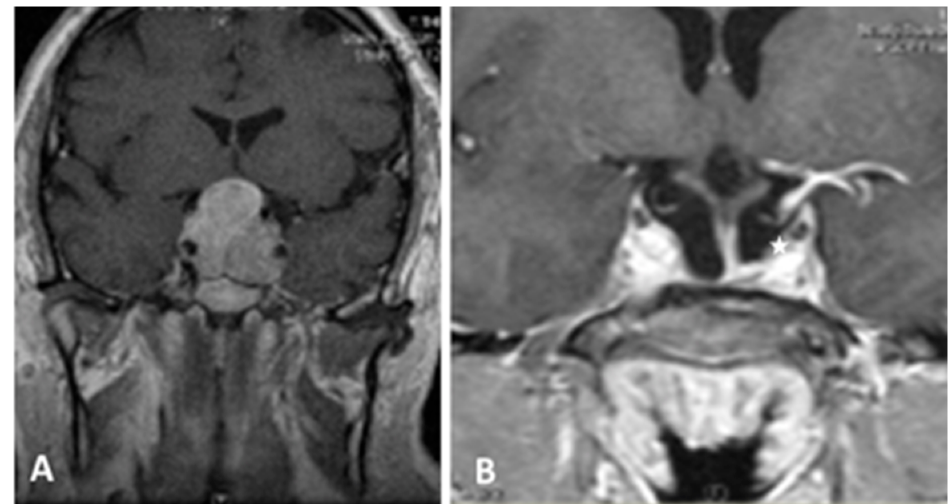
Figure 1. T1- weighted contrast-enhanced MR images. Preoperative sagittal ( A ) view showing a giant pituitary macroadenoma, Knosp grade 1. Three-month postoperative coronal ( B ) and sagittal ( C ) views showing GTR. GTR: gross total removal.